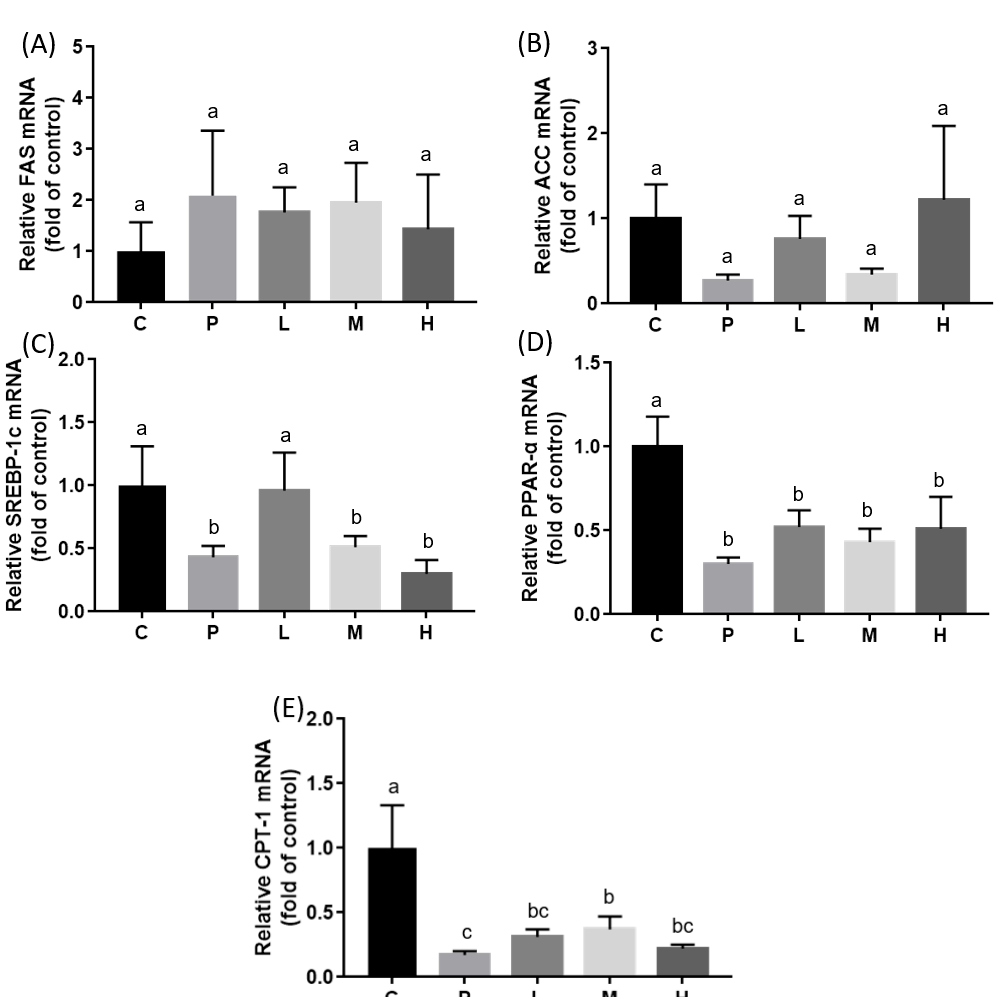
Figure 4. Hepatic mRNA expressions of ( A ) fatty acid synthase (FAS), ( B ) acetyl-CoA carboxylase (ACC), ( C ) sterol regulatory element-binding protein (SREBP)-1c, ( D ) peroxisome proliferator-activated receptor (PPAR)- α , and ( E ) carnitine palmitoyltransferase I (CPT)-I in hamsters fed an HFD after a melatonin intervention for eight weeks. Daily gavage administration of melatonin at 10 (L), 20 (M), or 50 (H) mg/kg, or the ethanol vehicle to hamsters fed an HFD (P) or control diet (C). All values are the mean ± SEM ( n = 6–8). Different letters (a, b, c) indicate a significant difference at p < 0.05 determined using two-way ANOVA.